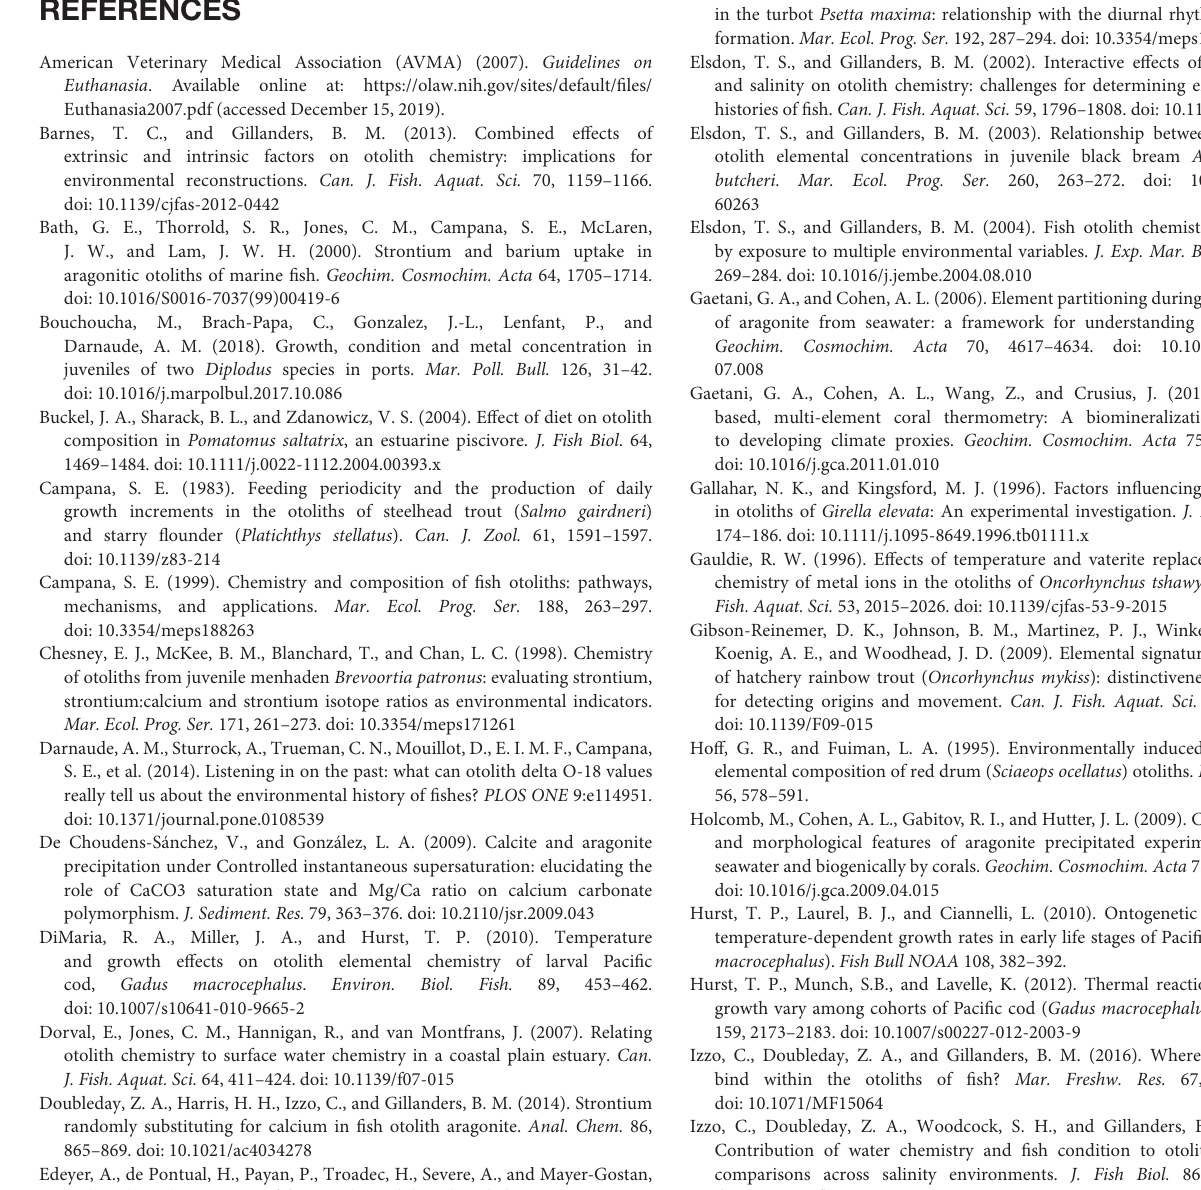
Table S1 | Water chemistry during experiment. Values represent the mean based on samples collected from two tanks on each day. For Ba:Ca and Mn:Ca, all standard deviations were less than 0.005. In order to calculate partition coefficients (DMe), water values were averaged based on duration of experiment within each treatment. Values were averaged from 10 Dec 09 to 09 Jan 10 for the 9 and 13 ◦ C full ration treatments, from 10 Dec 09 to 01 Feb 10 for the 9_low ◦ C restricted ration treatment, from 10 Dec 09 to 24 Feb 10 for the 5 ◦ C treatment, and from 10 Dec 09 to 25 Apr 10 for the 2 ◦ C treatment. “All” = 2, 5, 9_low, 9_high, and 13 ◦ C treatments. Table S2 | Results of the one-way Analyses of Variance completed to evaluate the effect of treatment (A) on fish length, specific growth rate, otolith increment width, and hepatosomatic index and the effect of temperature (B) or ration (C) on partition coefficients